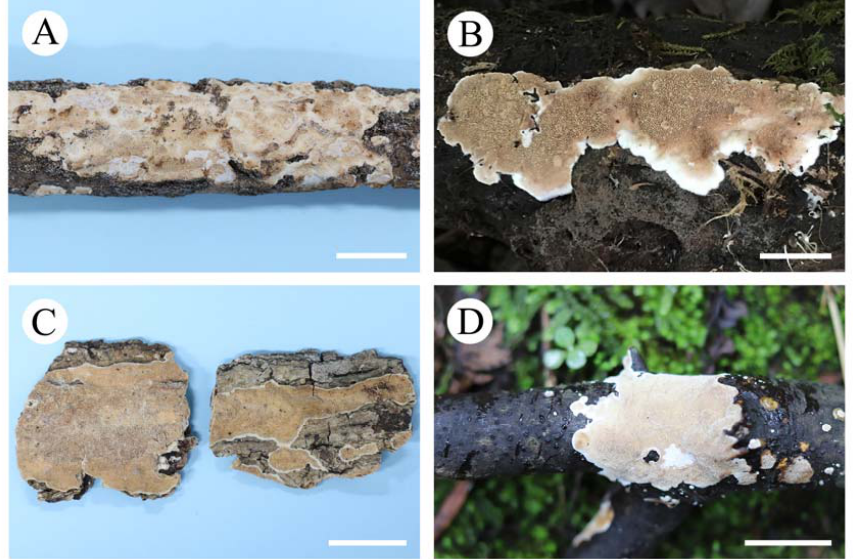
Figure 12. Basidiomes of Heteroradulum species. Scale bars: ( A–D ) = 1 cm. ( A ). H. maolanense (holotype, He 4773, BJFC 024290); ( B ). H. mussooriense (He 5331, BJFC 024849); ( C ). H. labyrinthinum (He 20120722-1, BJFC 014502); ( D ). H. labyrinthinum (He 5431, BJFC 026492). Heteroradulum labyrinthinum (H.S. Yuan & Decock) L.W. Zhou, MycoKeys 86: 97,